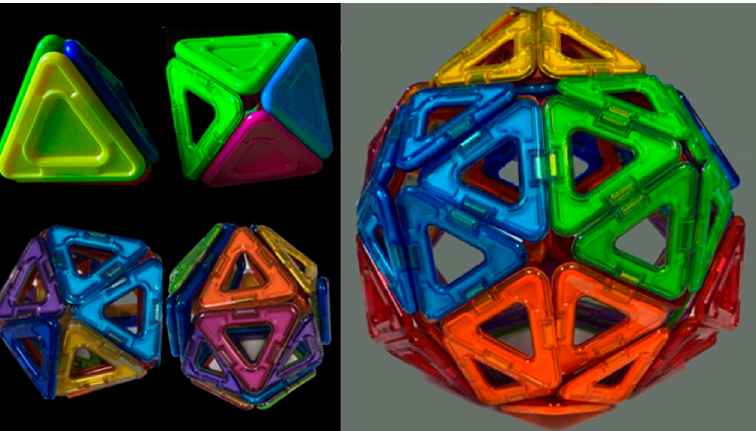
Figure 7. Equilateral triangular Magformers TM [19] units can be assembled to form tetrahedra, octahedra, decahedra, icosahedra and a T1-like 60-piece icosahedra.